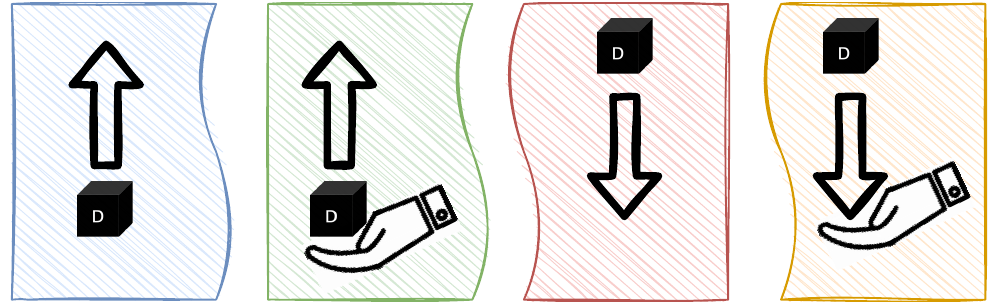
Figure 10. Basic operations Source: { Pick , Take } and Destination: { Place , Give }. These operations can be combined to form four complex operations, as depicted in Figure 11. Pick-Place is used to move a cube from one position to another. Take-Place is used to receive the cube from the user and place it on the table. Pick-Give is used to give a cube after picking it up. Take-Give action is logically exclusive, since the object does not change its position from the system’s perspective and thus can be neglected.